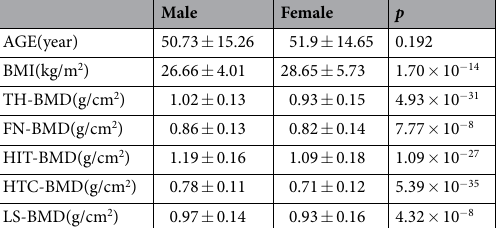
Table 1. Clinical characteristics of the study population (mean ± SD). TH-BMD: total hip BMD; HFN-BMD: